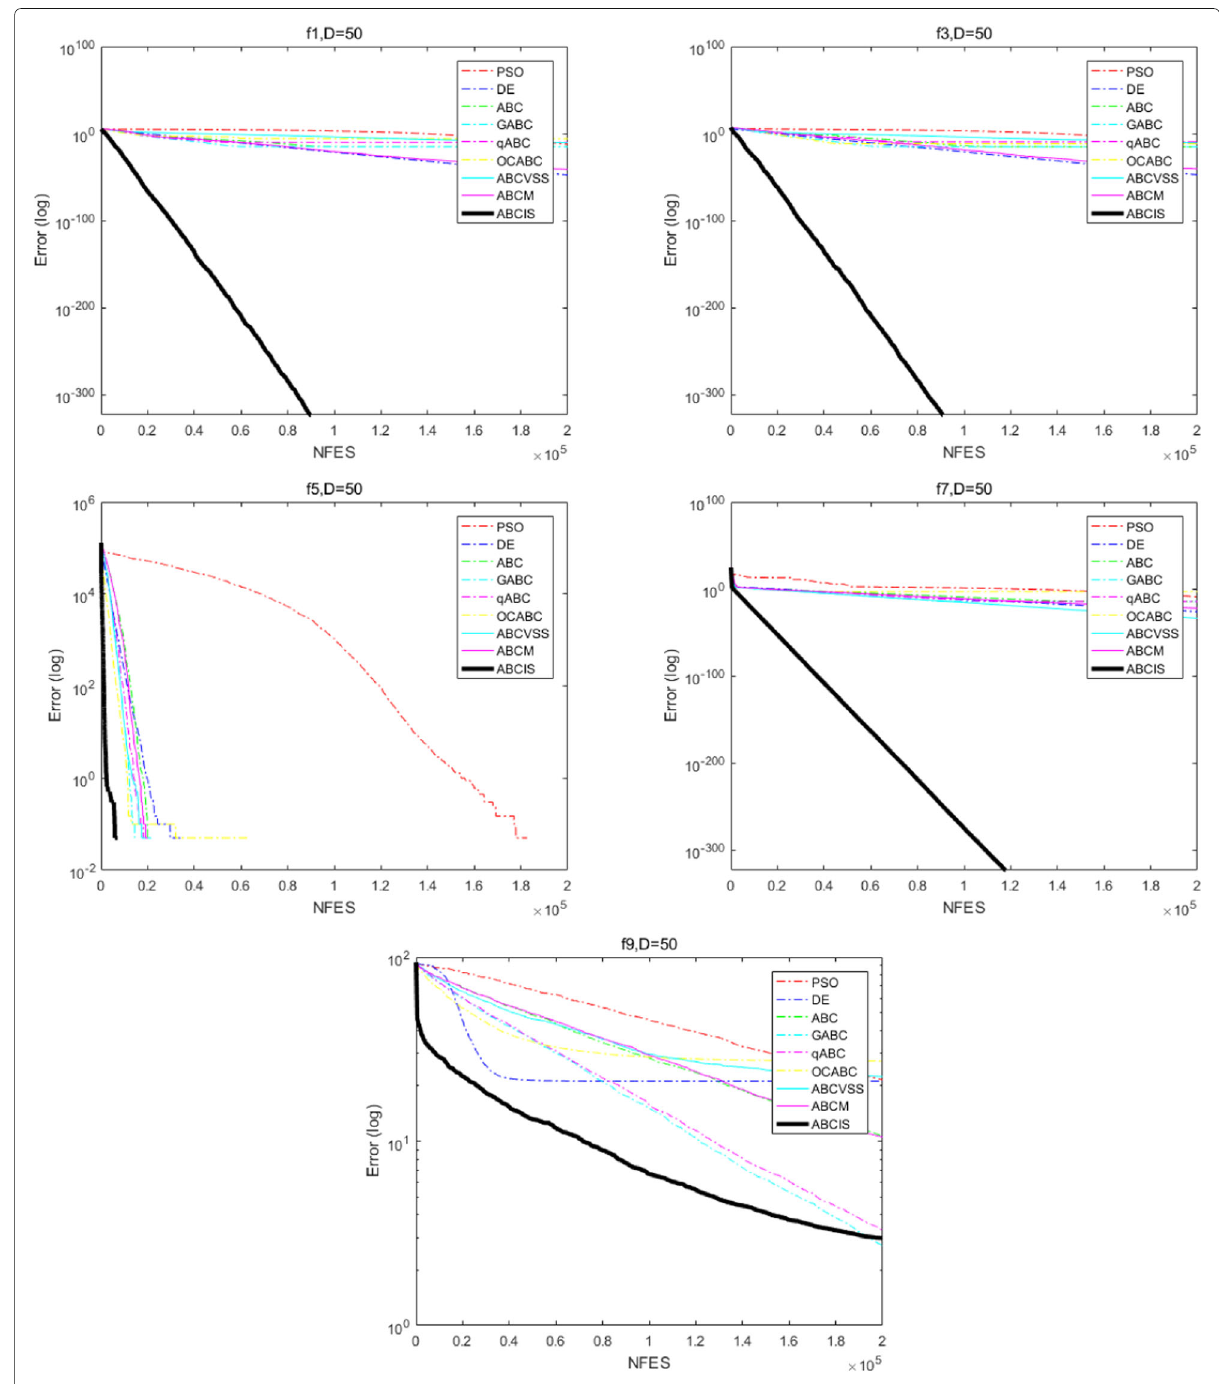
Fig. 5 Convergence curves, D = 50